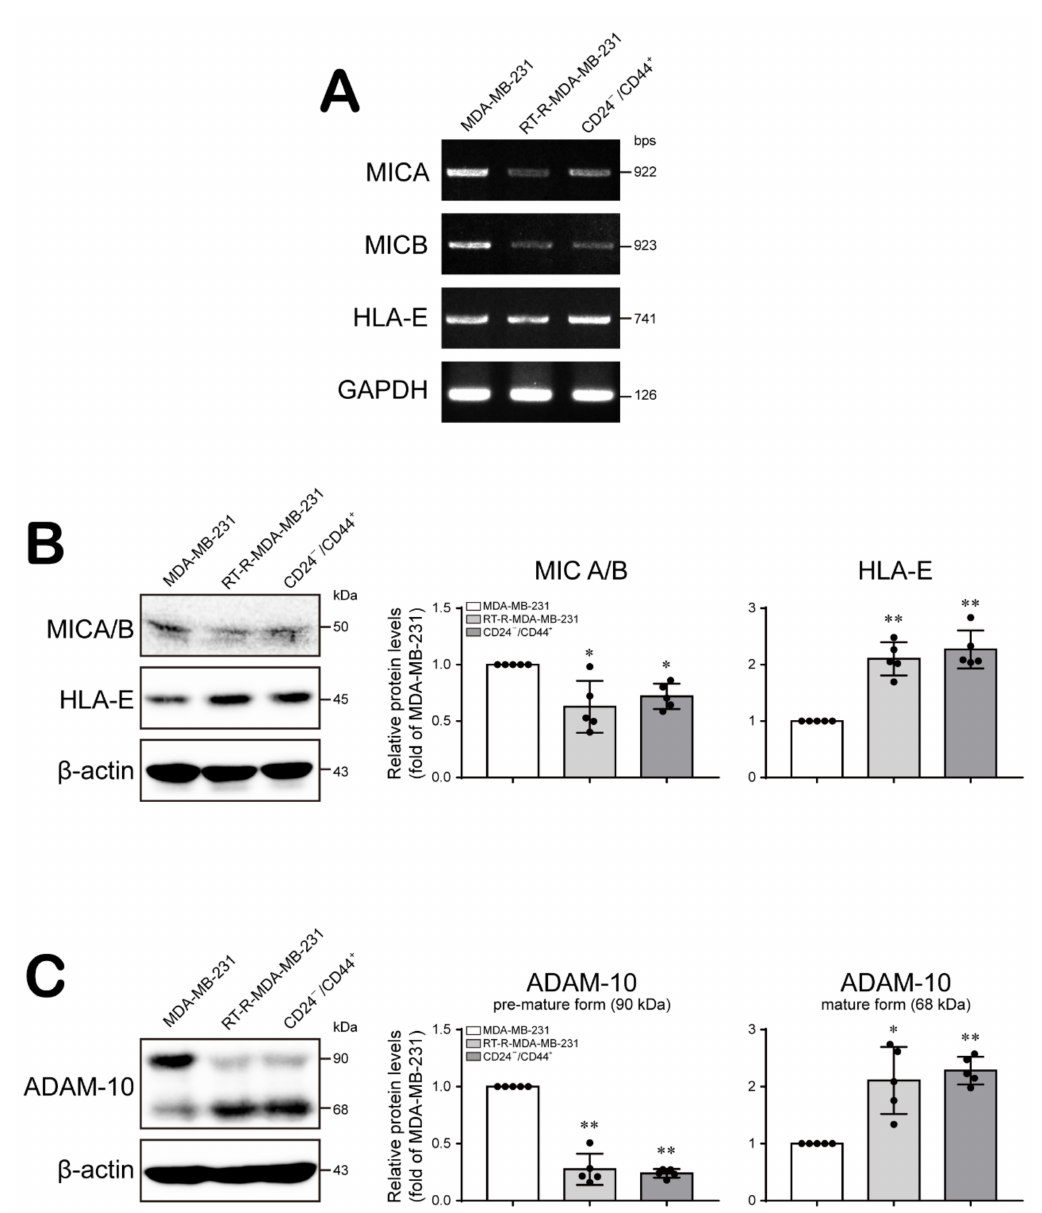
Figure 4. CD24 − /low /CD44 + BCSCs modulate the expression of sheddase, ADAM-10, and cell surface ligands for receptors of NK cells to regulate NK cell cytotoxicity. ( A , B ) The mRNA and protein expression levels of MICA/B and HLA-E were determined in MDA-MB-231, RT-R-MDA-MB-231, and CD24 − /low /CD44 + cells by RT-PCR ( A ) and Western blotting ( B ) as described in the Materials and Methods section. ( C ) The protein levels of the premature and mature forms of ADAM-10 were examined in MDA-MB-231, RT-R-MDA-MB-231, and CD24 − /low /CD44 + cells by Western blotting. GAPDH and β -actin were detected as loading controls. The values are presented as the mean ± SD of five independent experiments. * p < 0.05, ** p < 0.01 compared to MDA-MB-231